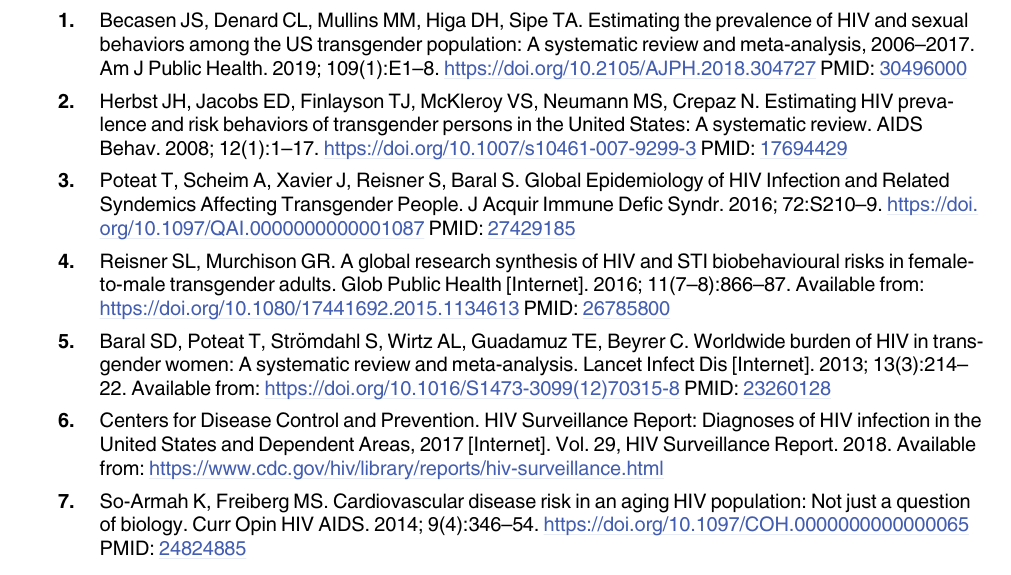
S1 Table. Medications specific to diabetes considered in